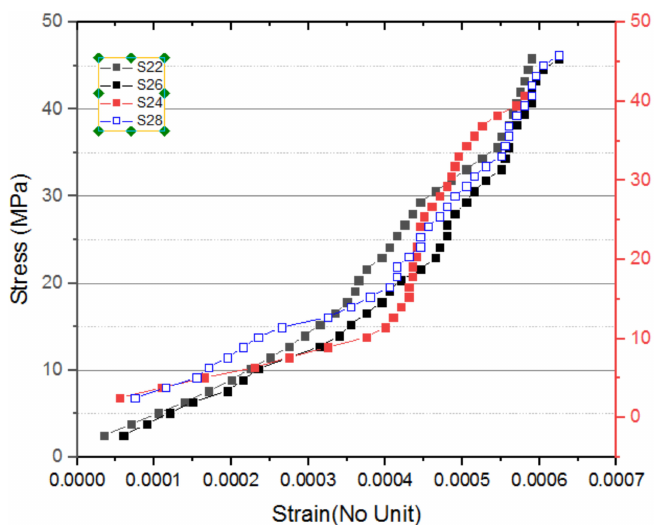
Figure 12. Stress–strain curve for S22 to S28.